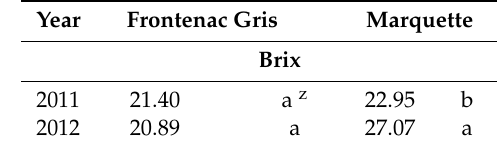
Table 8. E ff ect of year on soluble solid concentration at harvest for two V. riparia -based cultivars averaged over locations, retained primary buds, and fruit-zone leaf removal